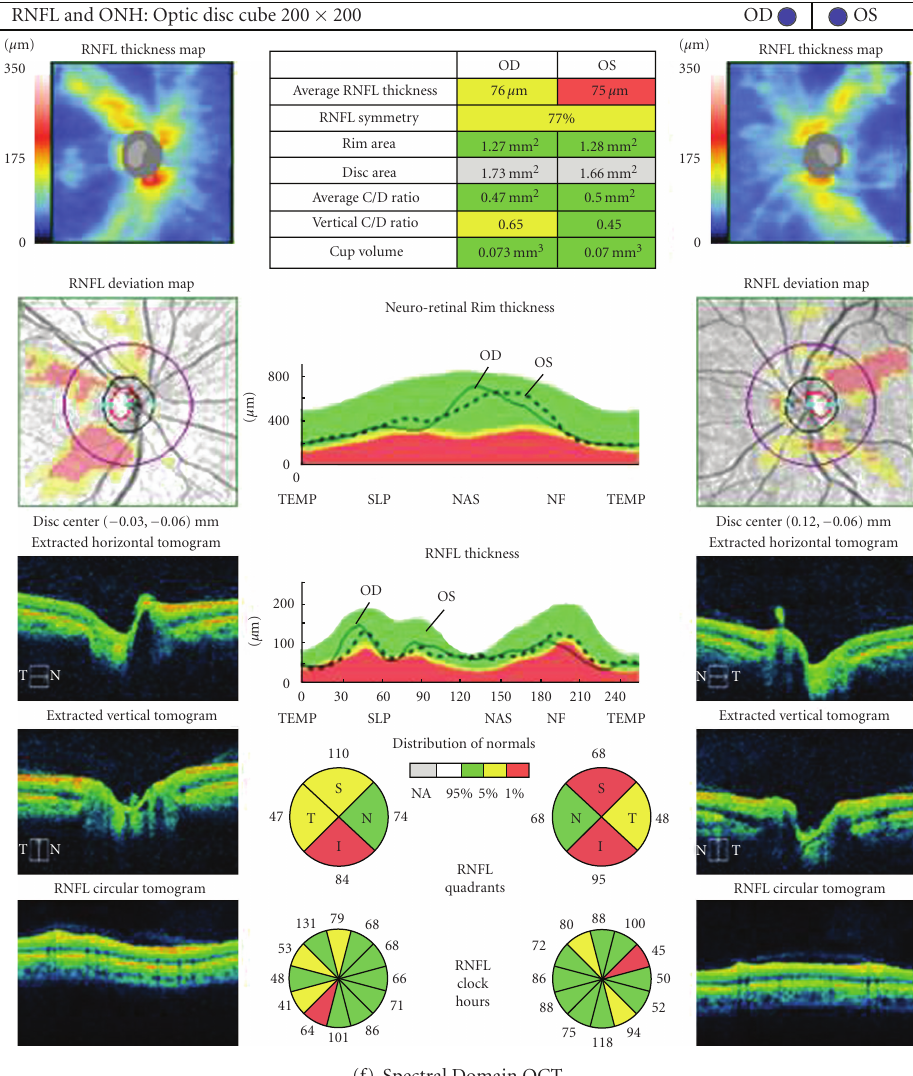
Figure 1: Case: A 26-year old woman with MS presented with a 2-month history of vision loss in both eyes. Best-corrected visual acuity was 20/150 in the right eye and count fingers (at 2 feet) in the left eye. There was a left relative a ff erent pupil defect. Fundus examination showed mild temporal pallor in the right (a) and left (b) eyes. Spectral domain OCT (c) showed that global average RNFL measurements were within normal limits in the right eye (OD) (87 μ m) and the left eye (OS) (90 μ m). There was relative temporal RNFL thinning in the left eye (arrow). Two and a half months later, the patient’s visual acuity improved to 20/20 in both eyes, albeit with mild residual color vision deficits. There was more obvious temporal pallor in the right (d) and left (e) eyes. Repeat SD-OCT testing (f) showed progressive global average RNFL atrophy in the right (OD) (76 μ m) and left (OS) eyes (75 μ m).